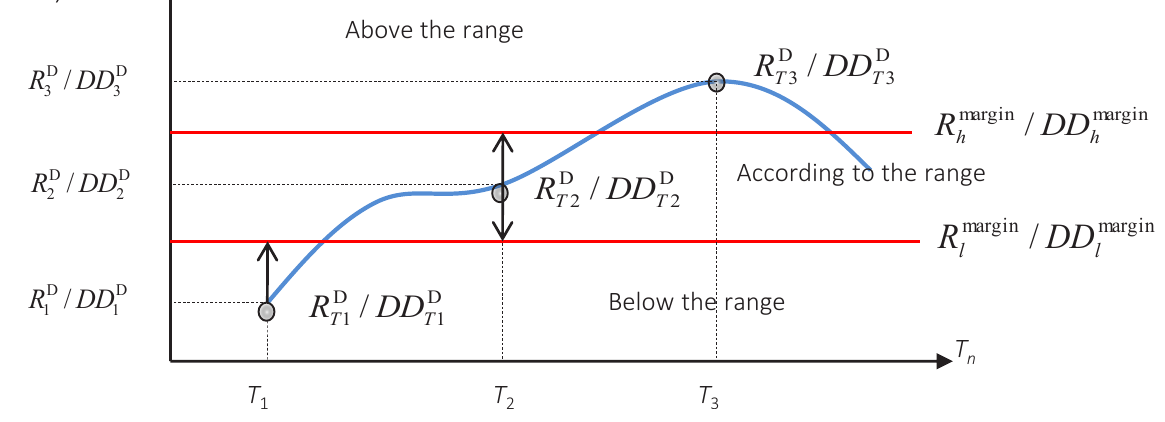
Figure 2. Graphical interpretation of the monitoring of the enterprise development dynamics to diversify projects in the enterprise